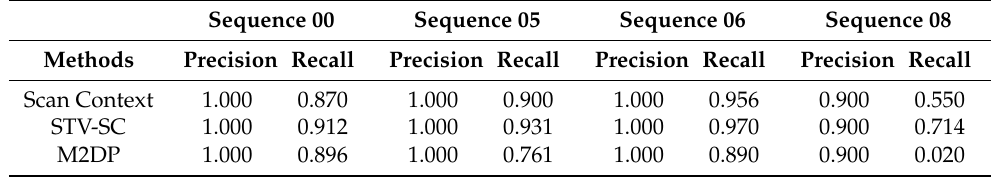
Figure 9. Precision-recall curves on KITTI dataset. ( a ) sequence 00; ( b ) sequence 05; ( c ) sequence 06; and ( d ) sequence 08. The performance of the algorithms is measured by the area enclosed by the curves and the coordinate axes. Table 3. Recall at 100% precision on KITTI 00, 05, and 06; Recall at 90% precision on KITTI